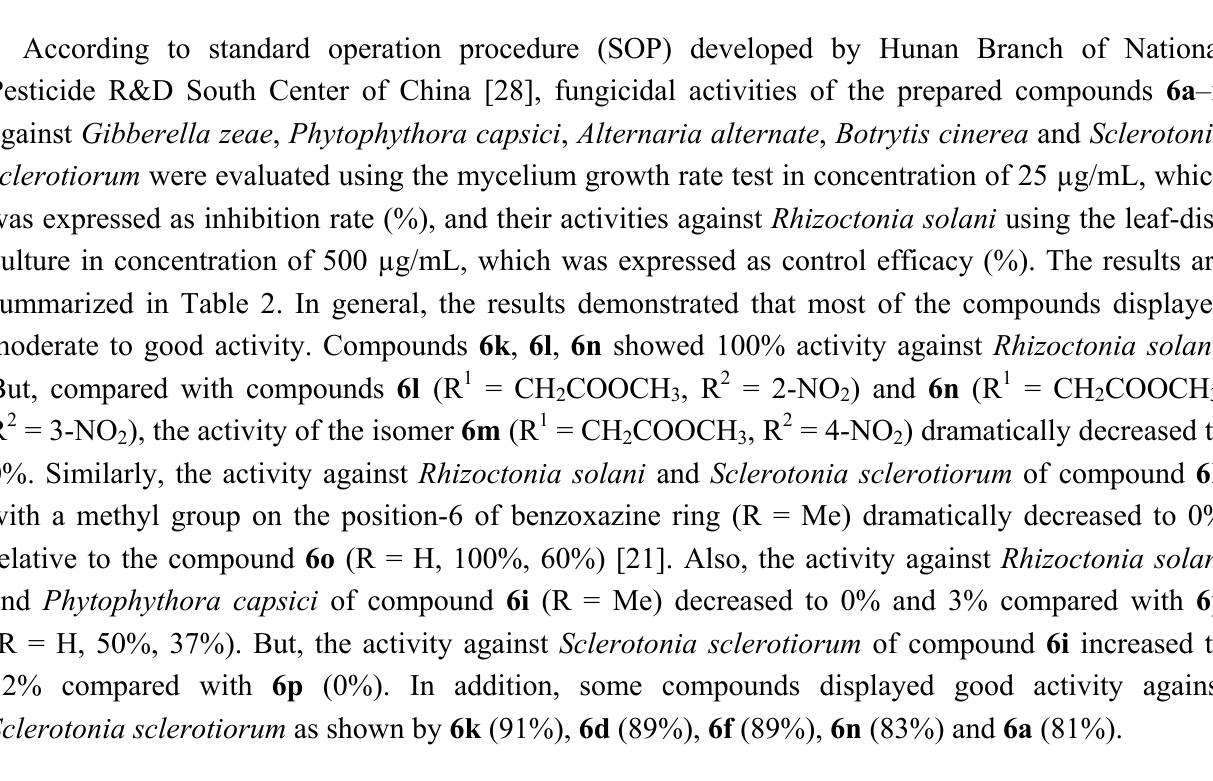
Table 2. Fungicidal activity of compounds 6a – n